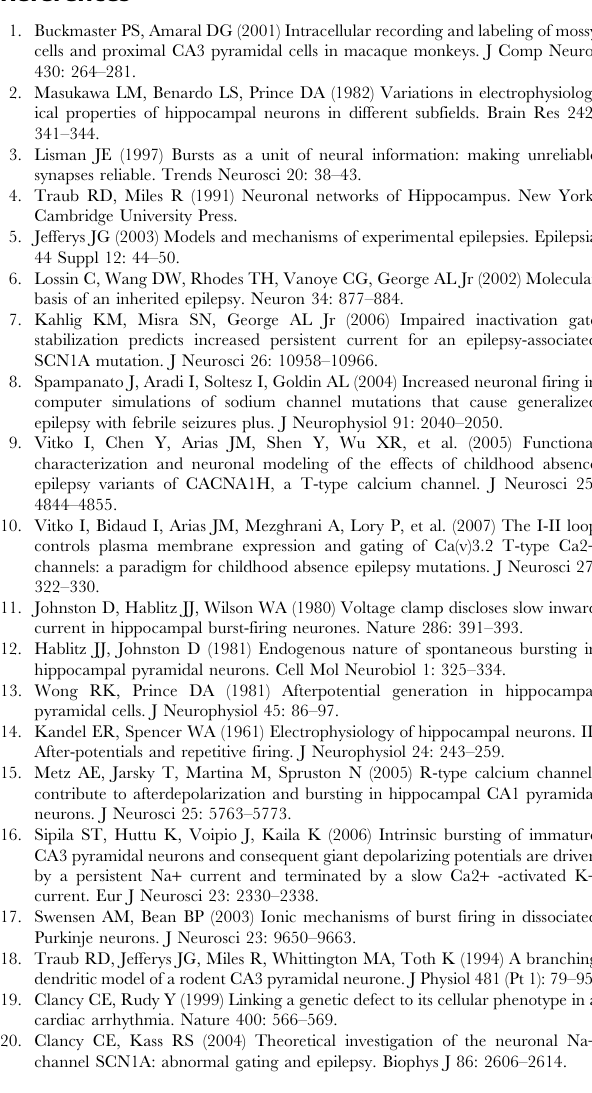
Figure S4 Fast slow analysis of bursting in a reduced CA3 model. The phase plot shows the projection of the burst trajectory onto the slow-variable n-o plane (n: the activation gate of CaV3.3; o: the activation gate of calcium-depend K + channel). Direction of movement is indicated with arrows. (A) gCaT = 0.1 mS/cm2; (B) gCaT = 6.0 mS/cm2; (C) gCaT = 7.0 mS/cm2; (D) gCaT = 8.0 mS/cm2; (E) gCaT = 9.0 mS/cm2; (F) gCaT =10.0 mS/ cm2. The red curve is the voltage nullcline (dV/dt =0) of the fast subsystem with n and o as parameters. The region above the nullcline is the unstable firing region. Below the curve is the stable rest region. Found at: doi:10.1371/journal.pone.0002056.g007 (0.69 MB